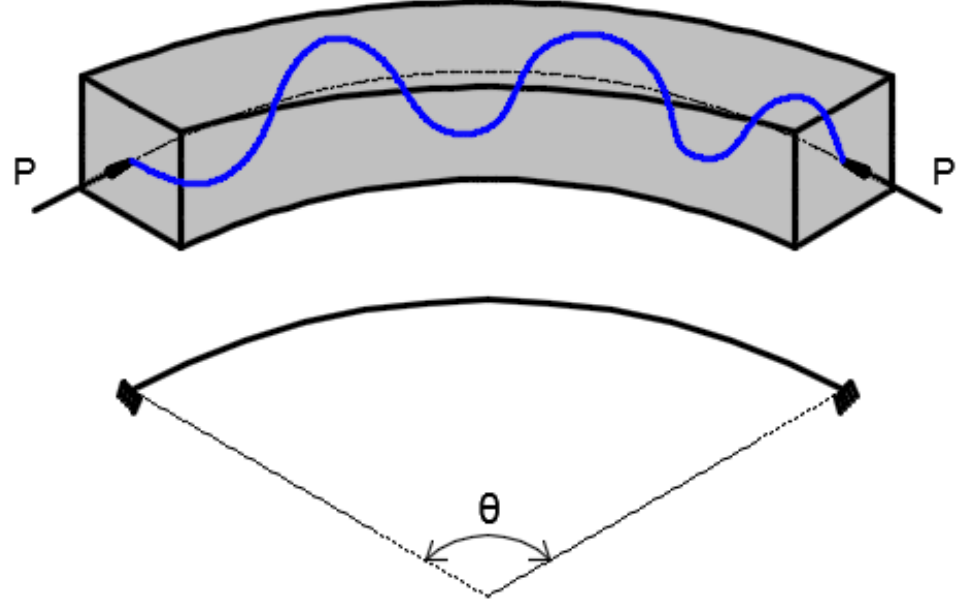
Figure 1. Curved fixed ends bar subjected to